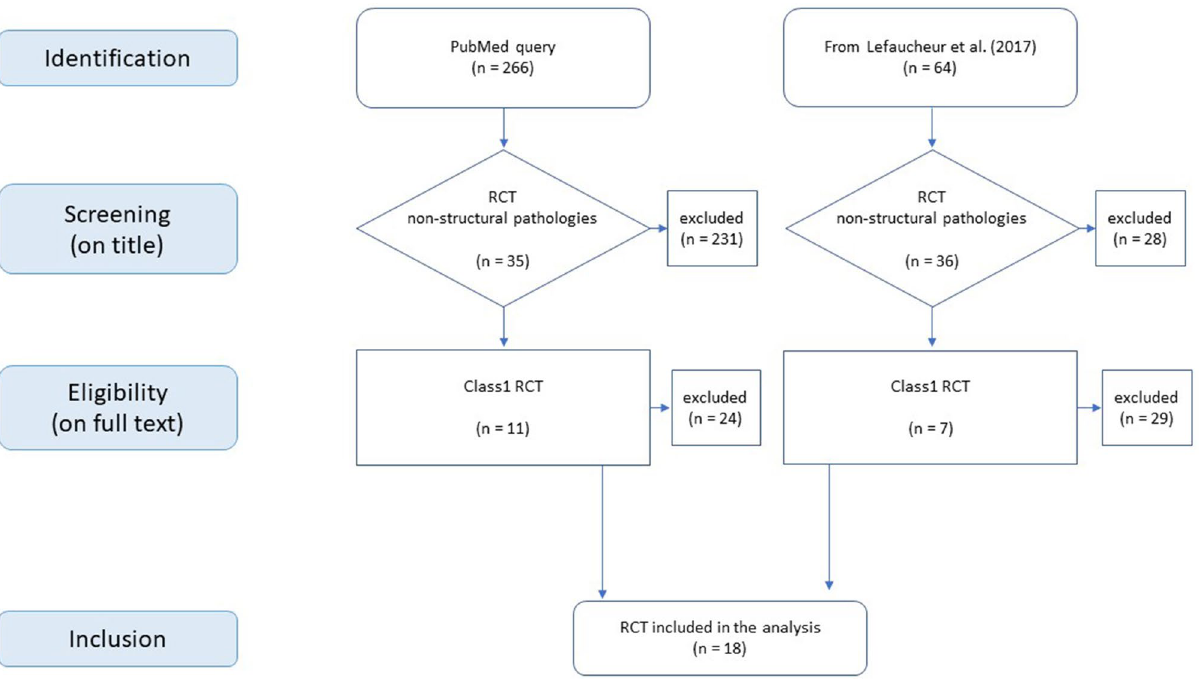
Figure 2. Flow chart. PRISMA flow diagram illustrating search strategy, inclusion and exclusion